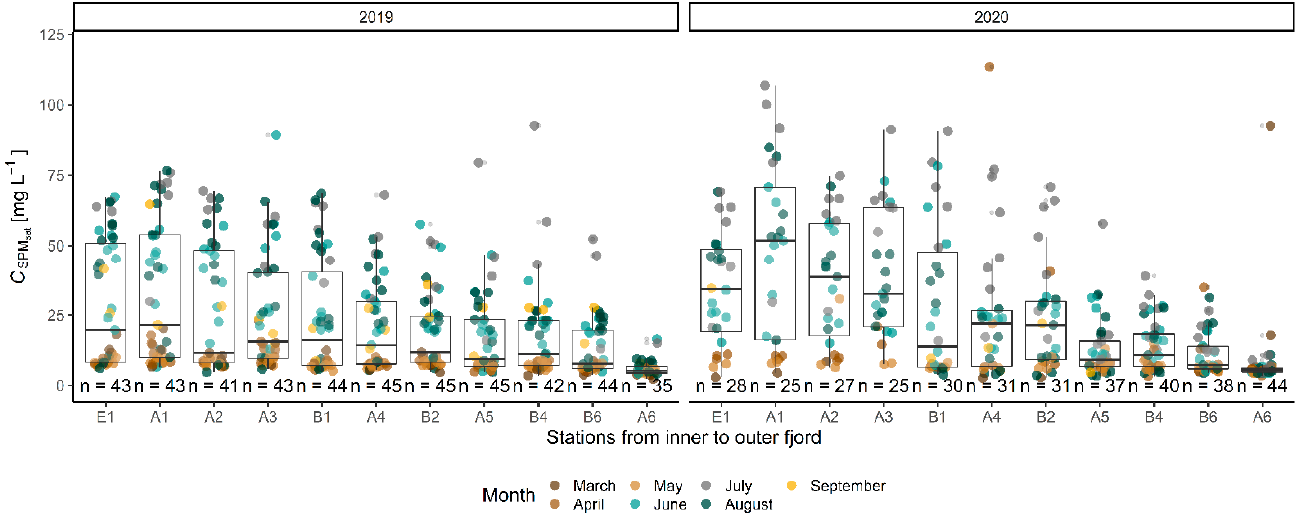
Figure 4. Box and whiskers plot with underlying point observations for C SPM stations in Adventfjorden in 2019 and 2020 (for FreshFate station grid see map in Figure 1). NVO (n) for each station are indicated below each boxplot. The stations are sorted from inner to outer fjord stations to illustrate spatial variability.